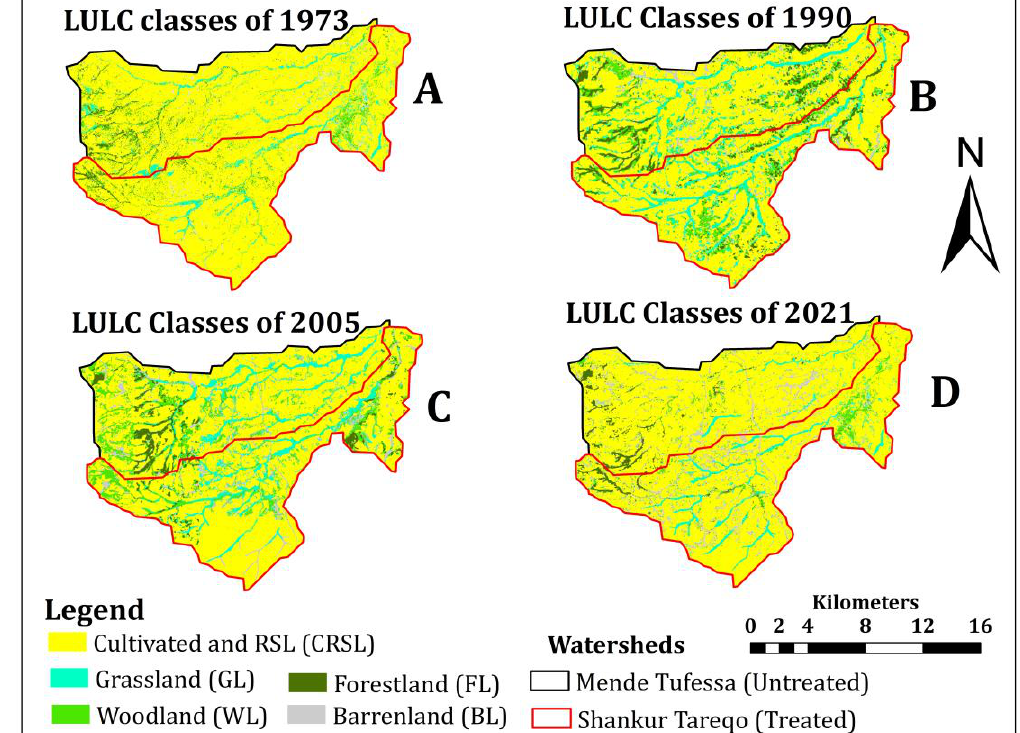
Fig. 3. LULC distribution of Shankur Tareqo and Mende Tufessa micro-watershed for each year from 1973 to